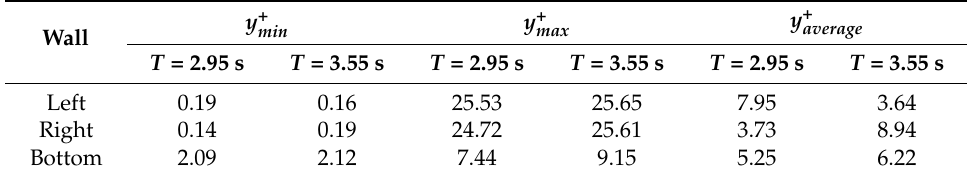
Table 1. Dimensionless wall distance at different instants of time.